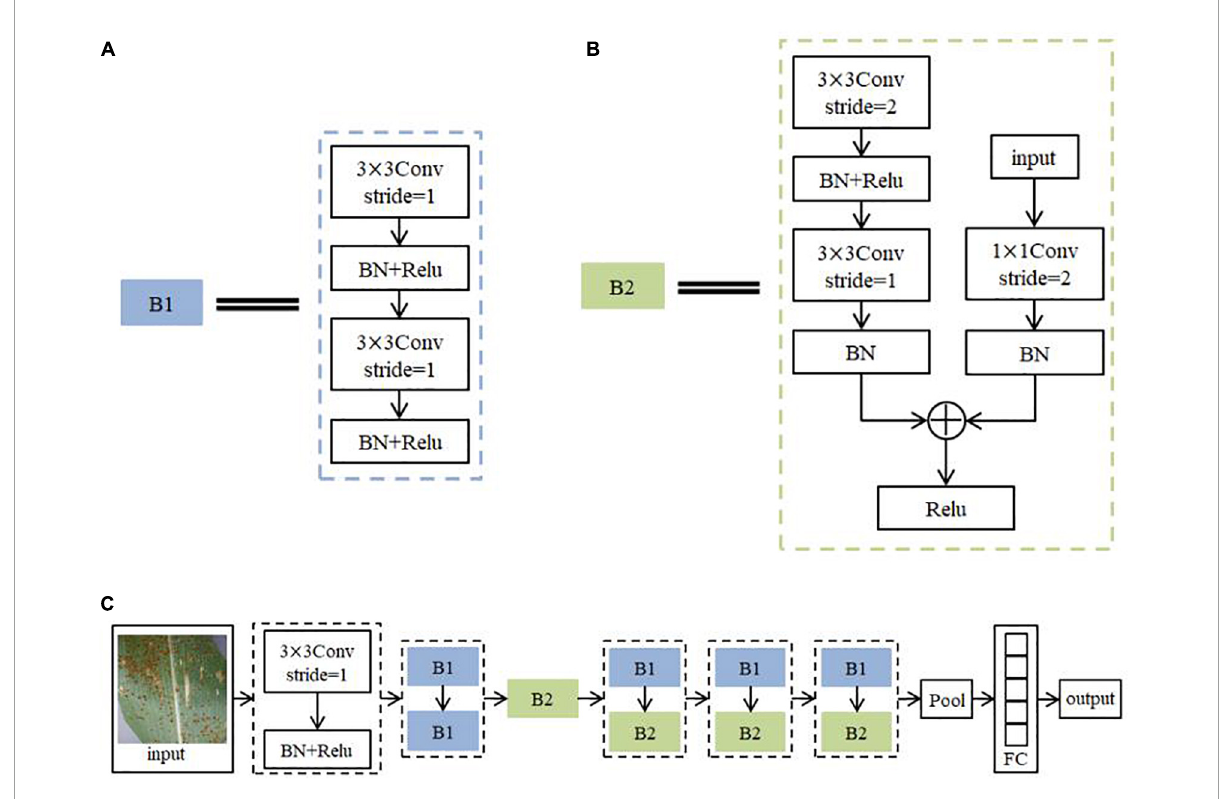
(3) The white patches generated above to represent the diseased spots are adjusted in gray scale. After performing color mapping, the color of the disease spots is adjusted by adjusting the value of HSI (Zhi et al., 2020). An image subtraction operation is performed with the original leaf texture mapping to generate the scattered spots of the disease in 2D view. After applying it to the 3D model, the final rendering result is